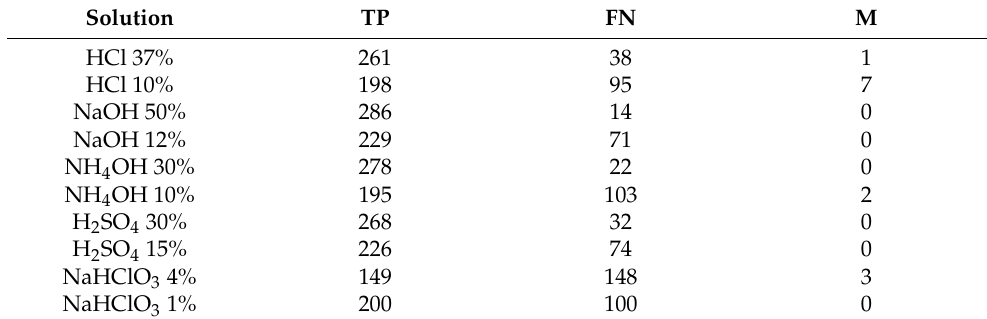
Table 2. Classification of corrosive solutions scanned through the walls of transparent and coloured PET and HDPE bottles using Model 1. TP = True Positives, FN = False Negatives, M = Misclassification.